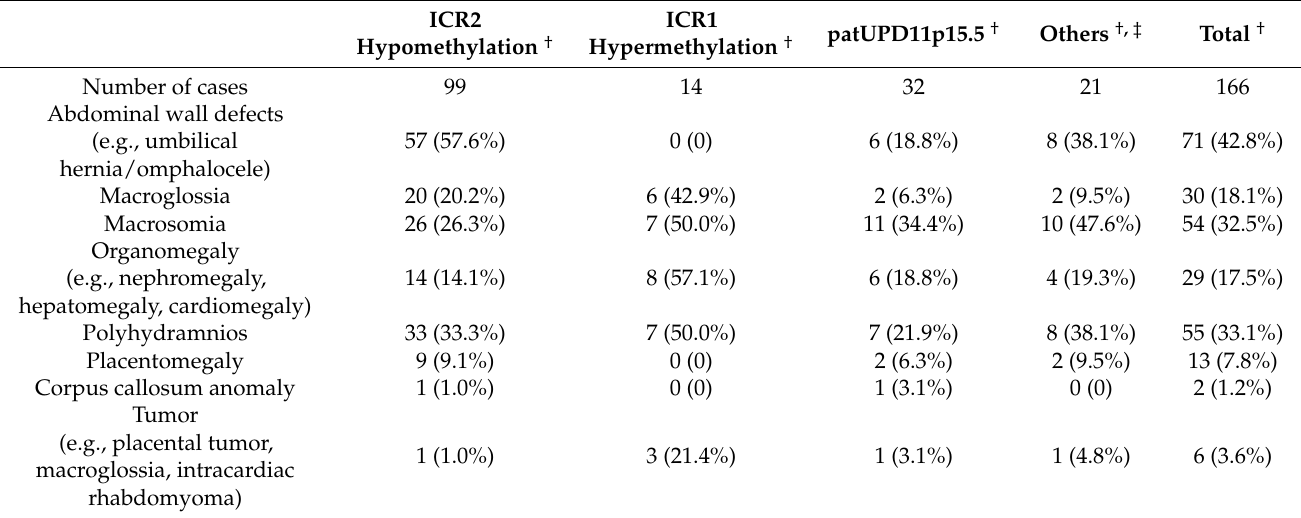
Table 1. Summary of the correlation of the prenatal features and genotypes of 166 reported BWS patients (see Table S1 for